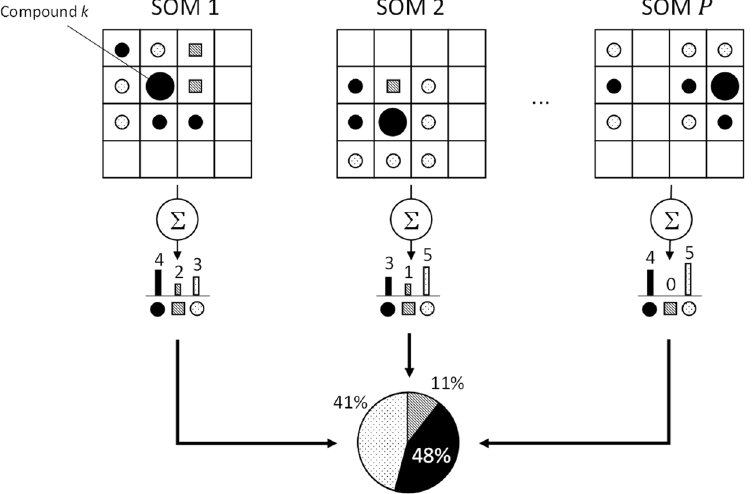
Figure 2. Schematic representation of the algorithm implemented to improve predictions in the boundaries. The neighbours of a given compound (k) can be different at each SOM run. With this algorithm, we would like to identify those coordinates that tend to locate in boundaries. The class of every neighbour is added and the total distribution is averaged over all calculated SOMs. Resulting probabilities were therefore used as prior probabilities in the expansion algorithm.